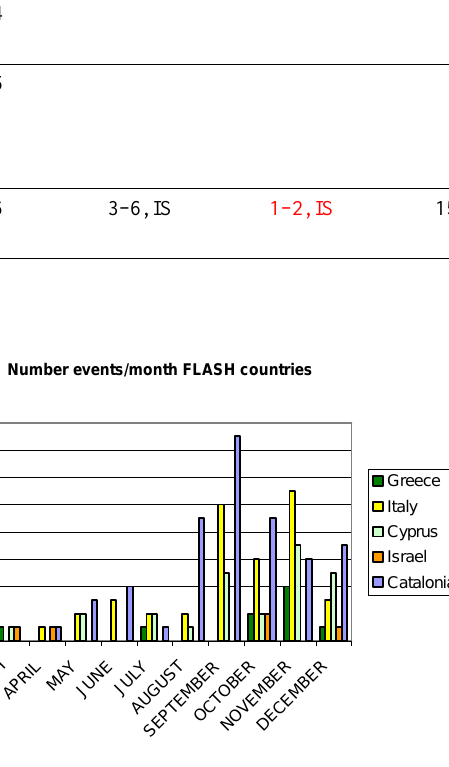
Fig. 4. Monthly distribution of floods in FLASH countries (1990– Fig. 4 . Monthly distribution of floods in FLASH countries (1990-2006).